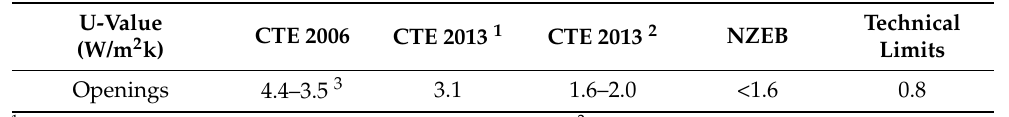
Table 3. Passive House parameters.